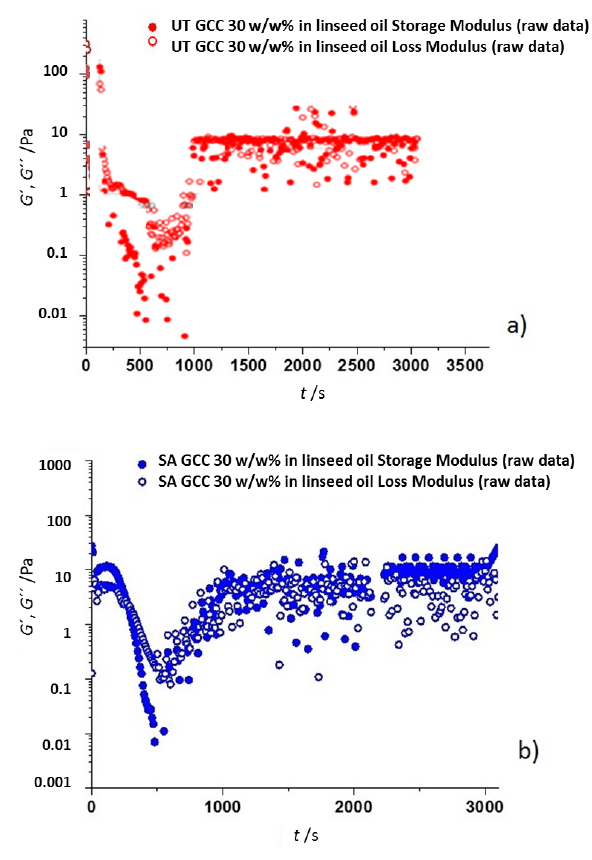
Figure 8: Viscoelastic stress moduli reduction and recovery under oscillation as strain is ramped up and then down – finally measure- ments continue under conditions of constant low-level strain: (a) untreated UT GCC at 20 w/w% solids in linseed oil, (b) fatty acid treated SA GCC at 20 w/w% solids in linseed.